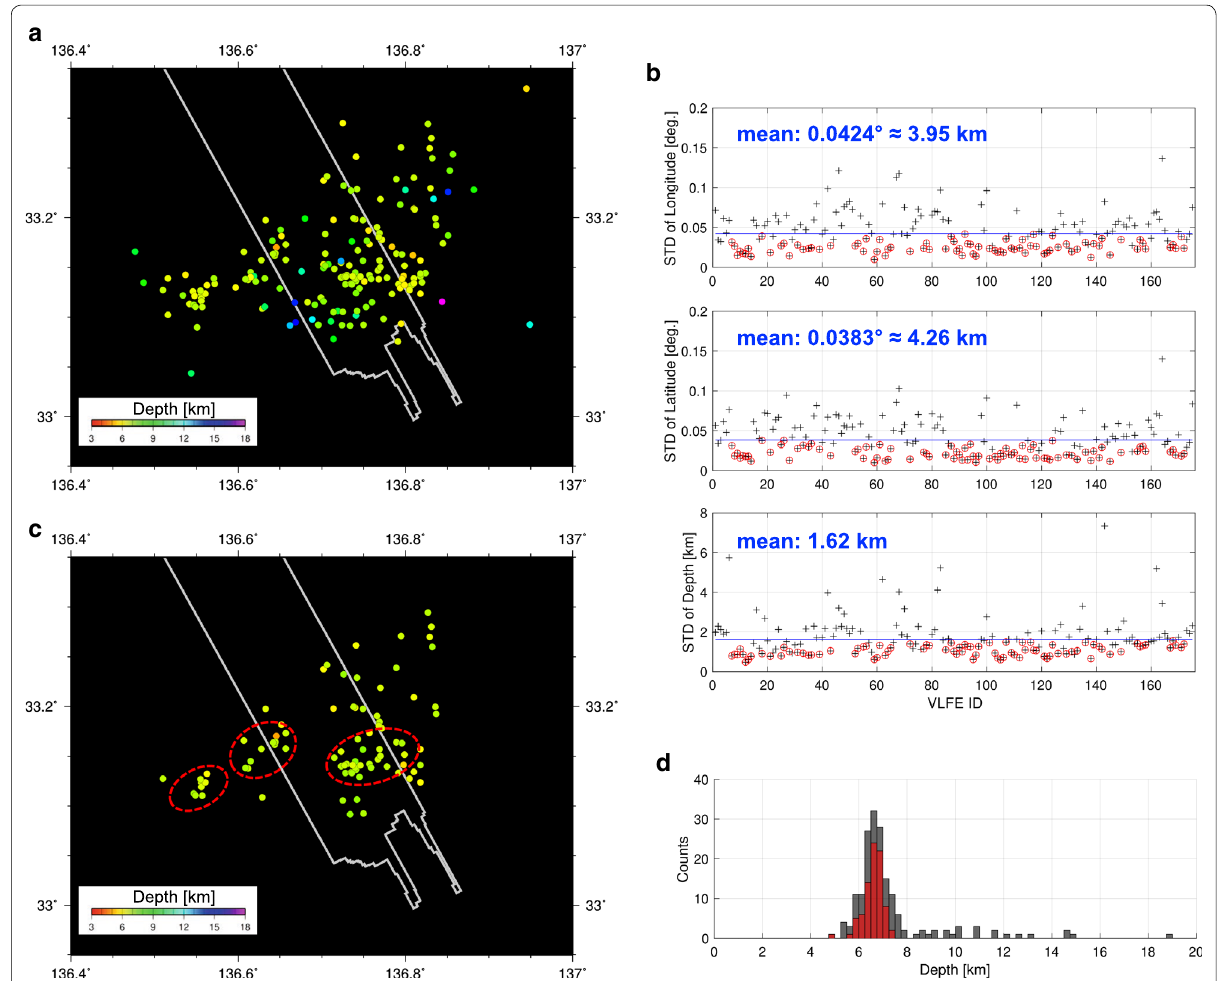
Fig. 6 a Distribution of VLFE sources (Nakano et al. 2018). b Standard errors of the VLFE source locations in the longitude, latitude, and depth directions (black crosses). The red circles indicate VLFE sources whose errors are lower than the mean value of the standard deviation (STD) for each direction. c The distribution of VLFEs with location errors smaller than the mean value of the STD; the red dashed circles indicate VLFE clusters. d Histograms of the depth distribution of the original (gray) and selected (red)